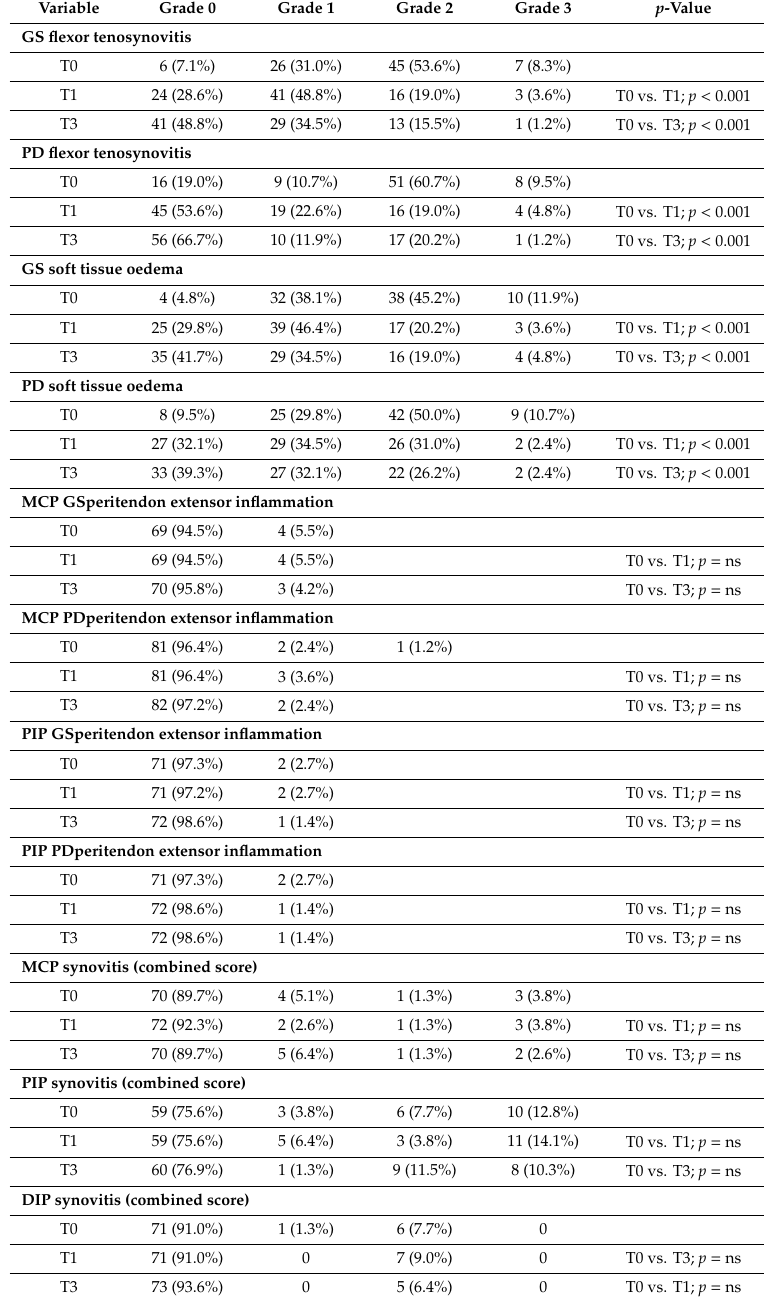
Table 2. Prevalence of ultrasound abnormalities observed in 83 dactylitic fingers from 49 psoriatic arthritis patients evaluated at baseline, 1 month, and 3